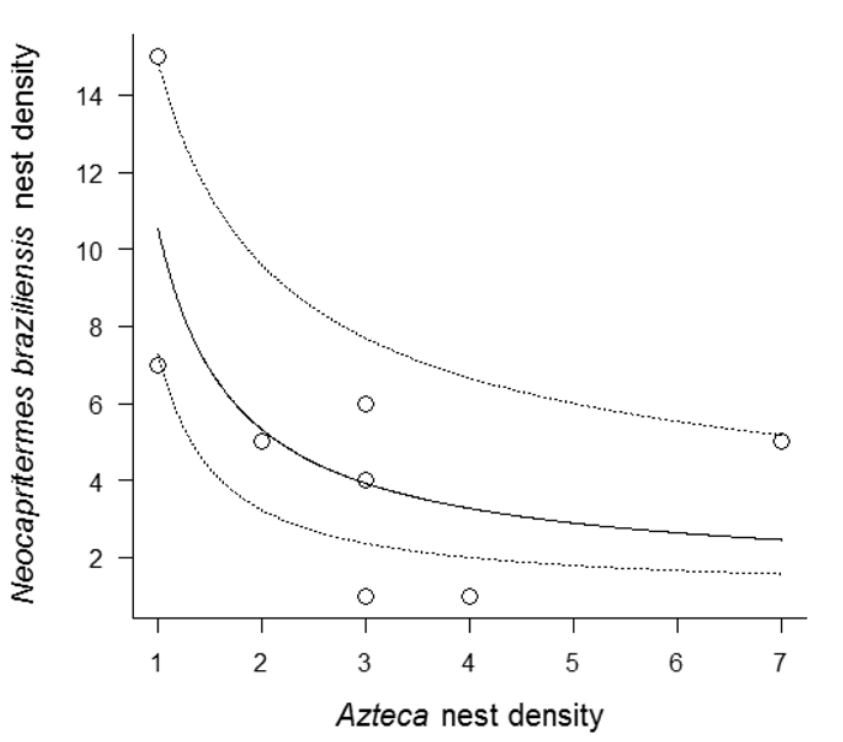
Fig.1. Mean response (solid line) of Neocapritermes braziliensis ’ nest density to Azteca ’s, estimated as log(Y) = 2.35 . X -0.49 . Dotted lines are 95% credible